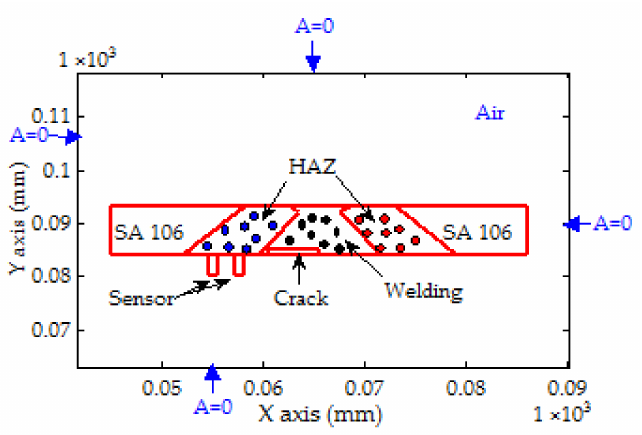
Figure 7. Solving domain and boundary